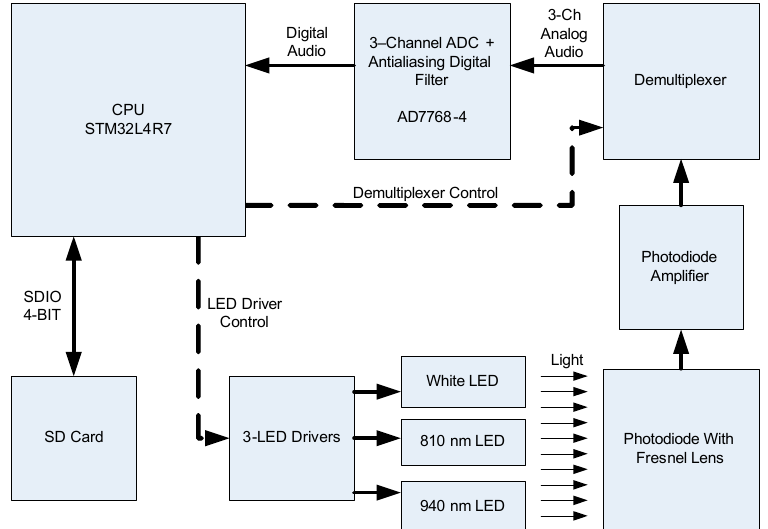
Figure 2. Block diagram of the multispectral device. The system is controlled from an STM32L4R7 ARM CPU of ST. The LED drivers produces the sequentially current pulses of each LED. Powering of the LEDs is carried out through the TPS54302 IC of Texas Instruments (Figure A7 left) and the device state (trigger, SD card, power status) is indicated in the front LEDs of the device (Figure A7 right).